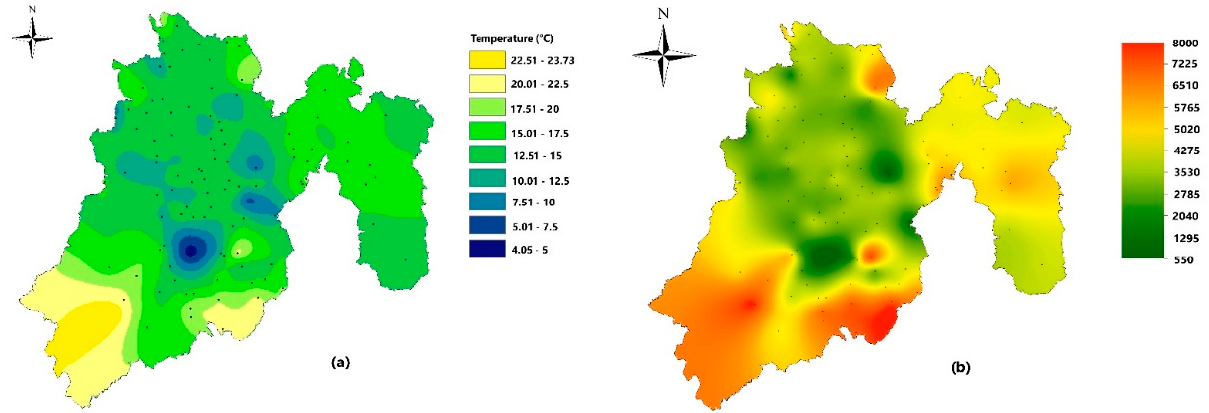
Figure 6. Spatial representation of ( a ) annual average temperature (°C) and ( b ) Calculated annual GTE for the state of Mexico, Mexico.